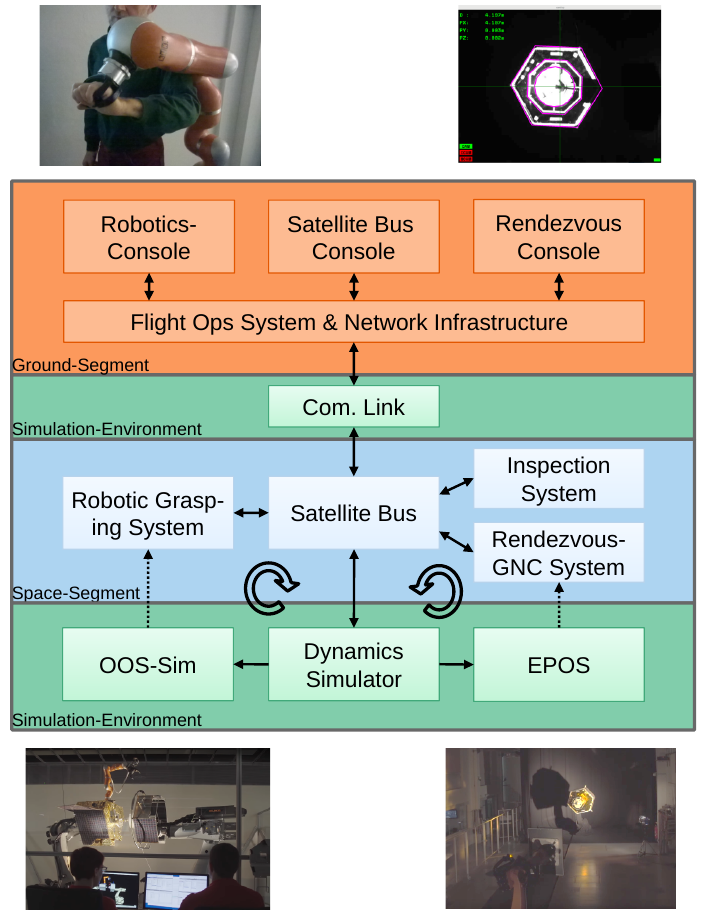
Figure 14. Overview of OOS-E2E simulation